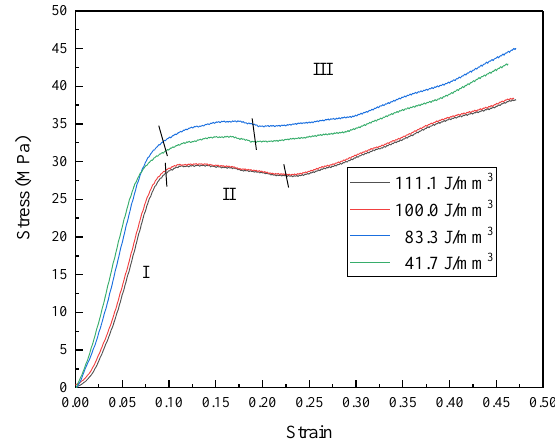
Figure 16. Stress–strain curve of the FCC structure. Table 6. Compression deformation process of the FCC structure.